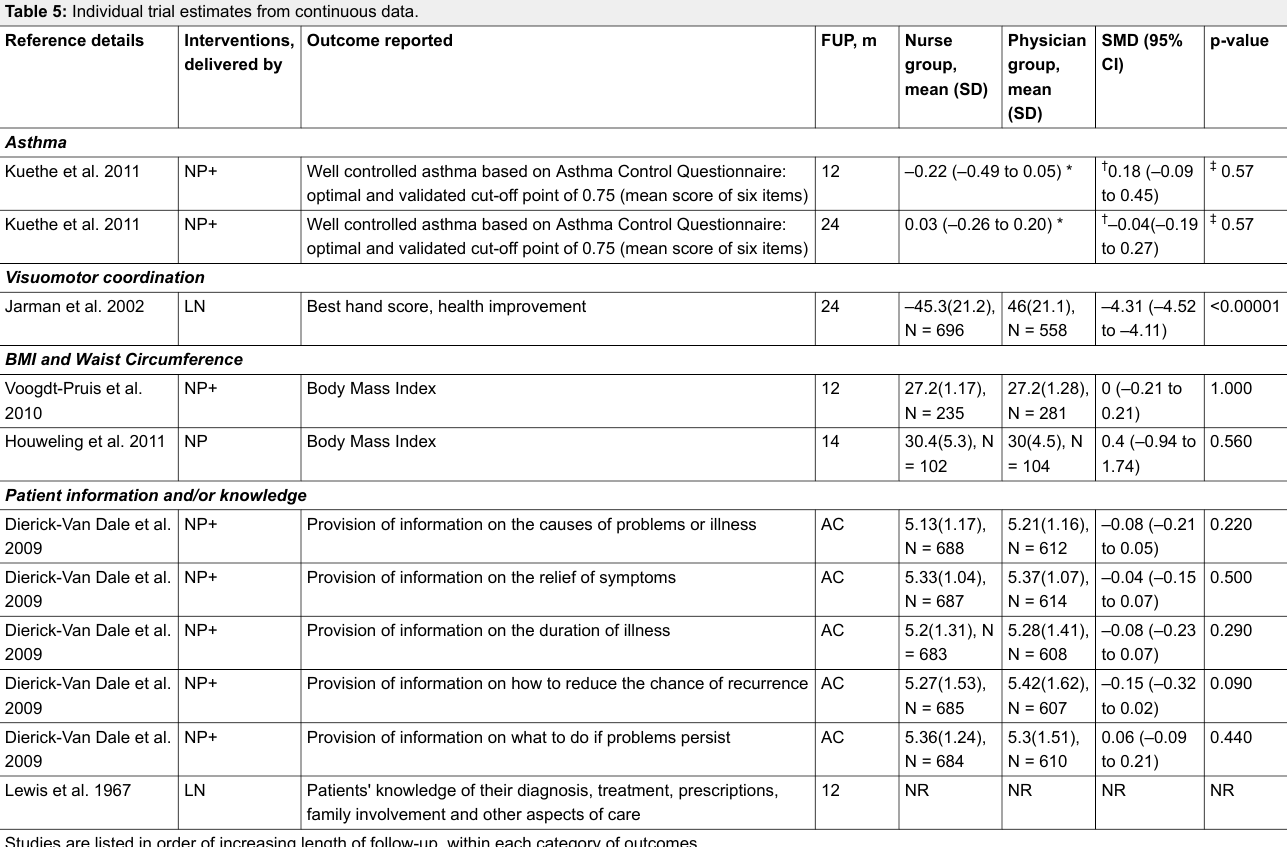
Table 5: Individual trial estimates from continuous